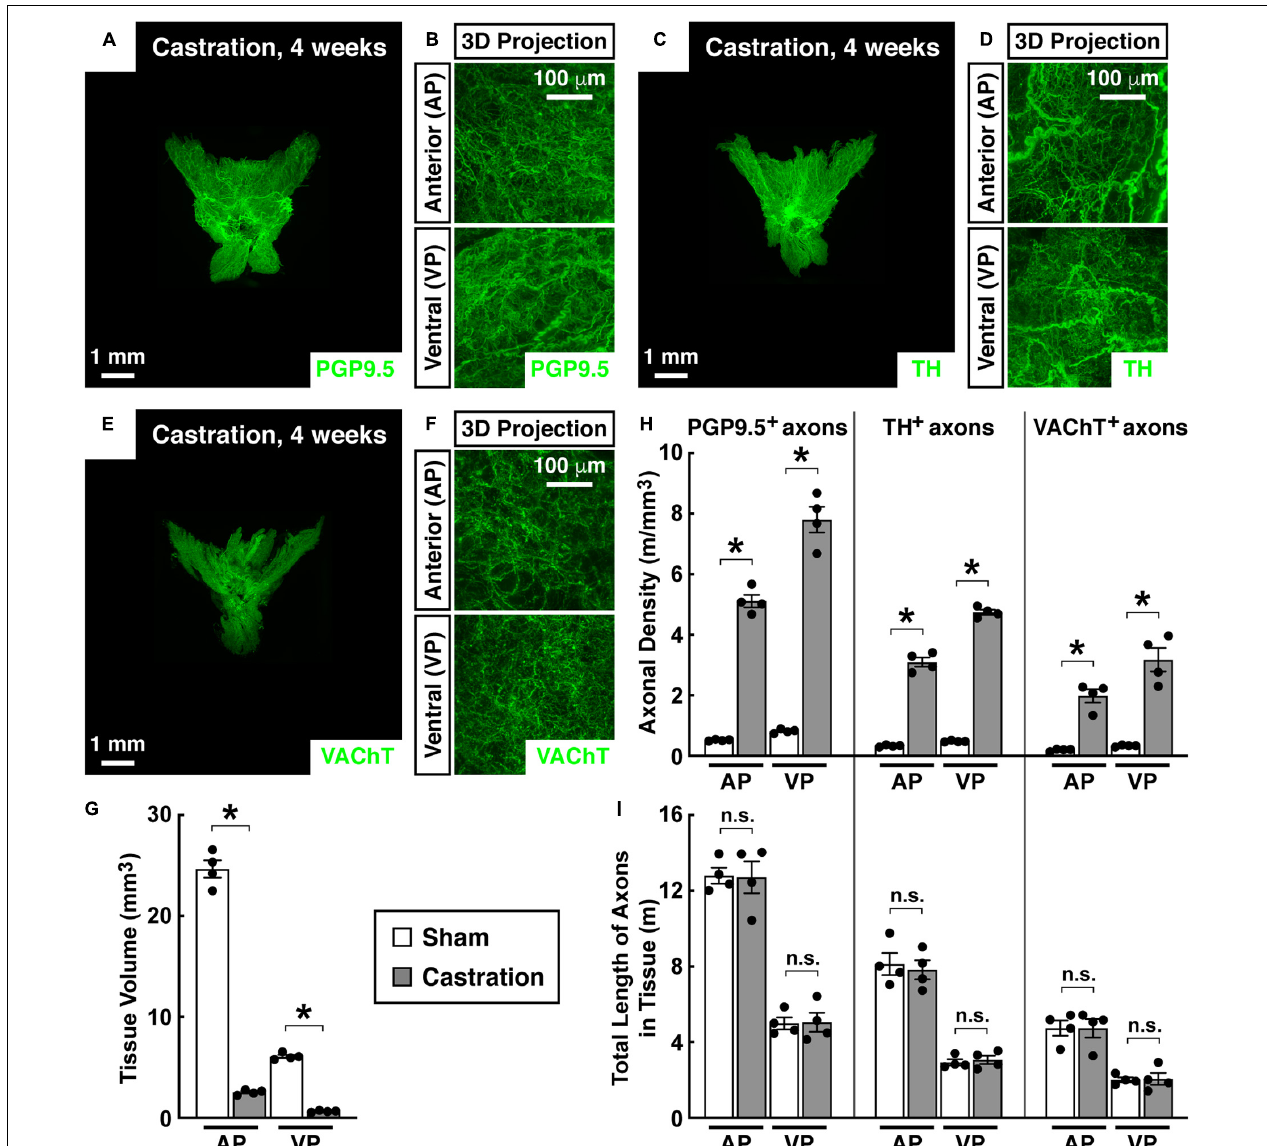
FIGURE 3 | Autonomic innervations were unaffected in the mouse prostate after castration. Eight-week-old male mice were castrated. Four weeks after castration, the intact prostates were harvested and subjected to the whole-tissue immunolabeling of PGP9.5 (A,B) , TH (C,D) , or VAChT (E,F) . (A,C,E) Representative 3D projections of the lightsheet imaging are shown. (B,D,F) Representative 3D projections of the 1-mm thickness of the anterior (AP) and ventral prostate (VP) of the lightsheet imaging are shown. (G) Tissue volumes of the anterior (AP) and ventral prostate (VP) of the mice that underwent castration or sham surgery were quantified. n = 4, mean ± SEM, * p < 0.05 (two-way ANOVA test). (H) The density of PGP9.5-positive total axons, TH-positive sympathetic axons, or VAChT-positive parasympathetic axons in the anterior (AP) and ventral prostate (VP) was quantified. n = 4, mean ± SEM, * p < 0.05 (two-way ANOVA test). (I) The total length